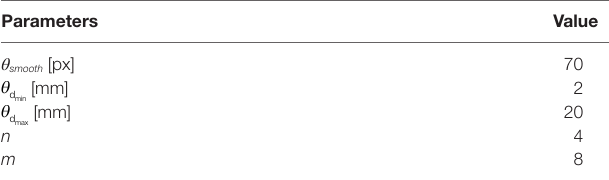
TaBle 2 | Parameters used in the